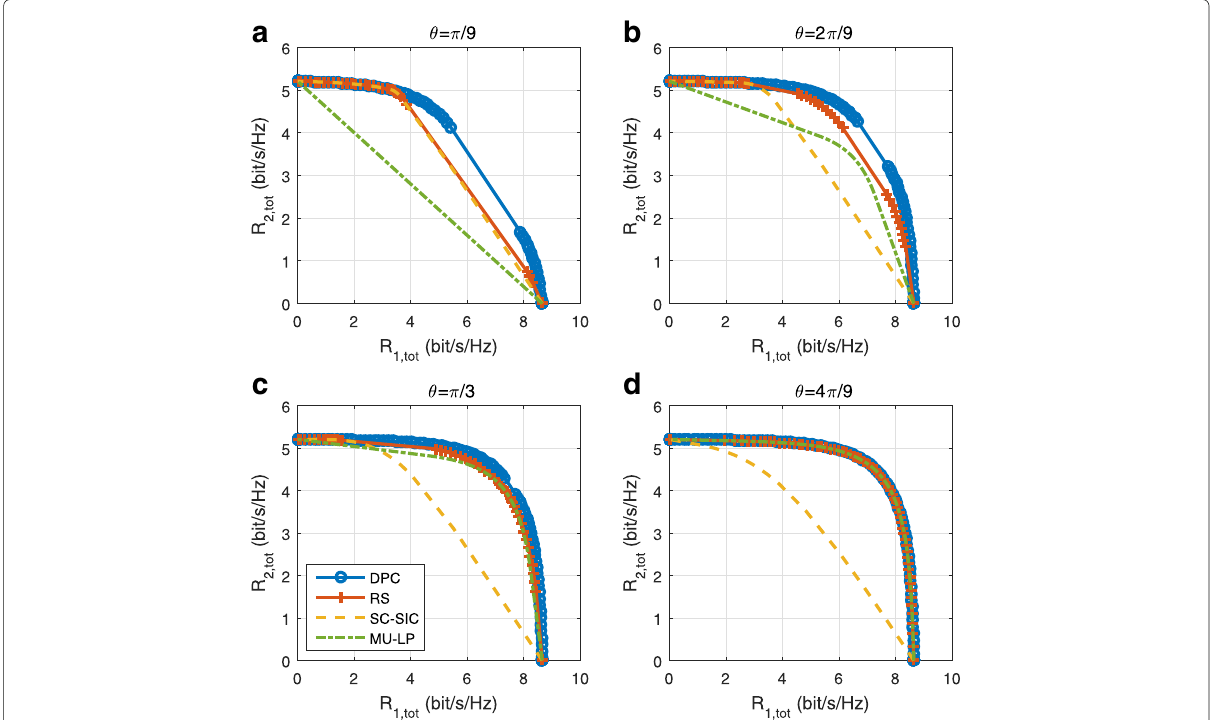
Fig. 9 Achievable rate region comparison of different strategies in perfect CSIT, γ = 0.3, N t = 4, SNR = 20 dB. a θ = π/ 9. b θ = 2 π/ 9. c θ = π/ 3. d θ = 4 π/